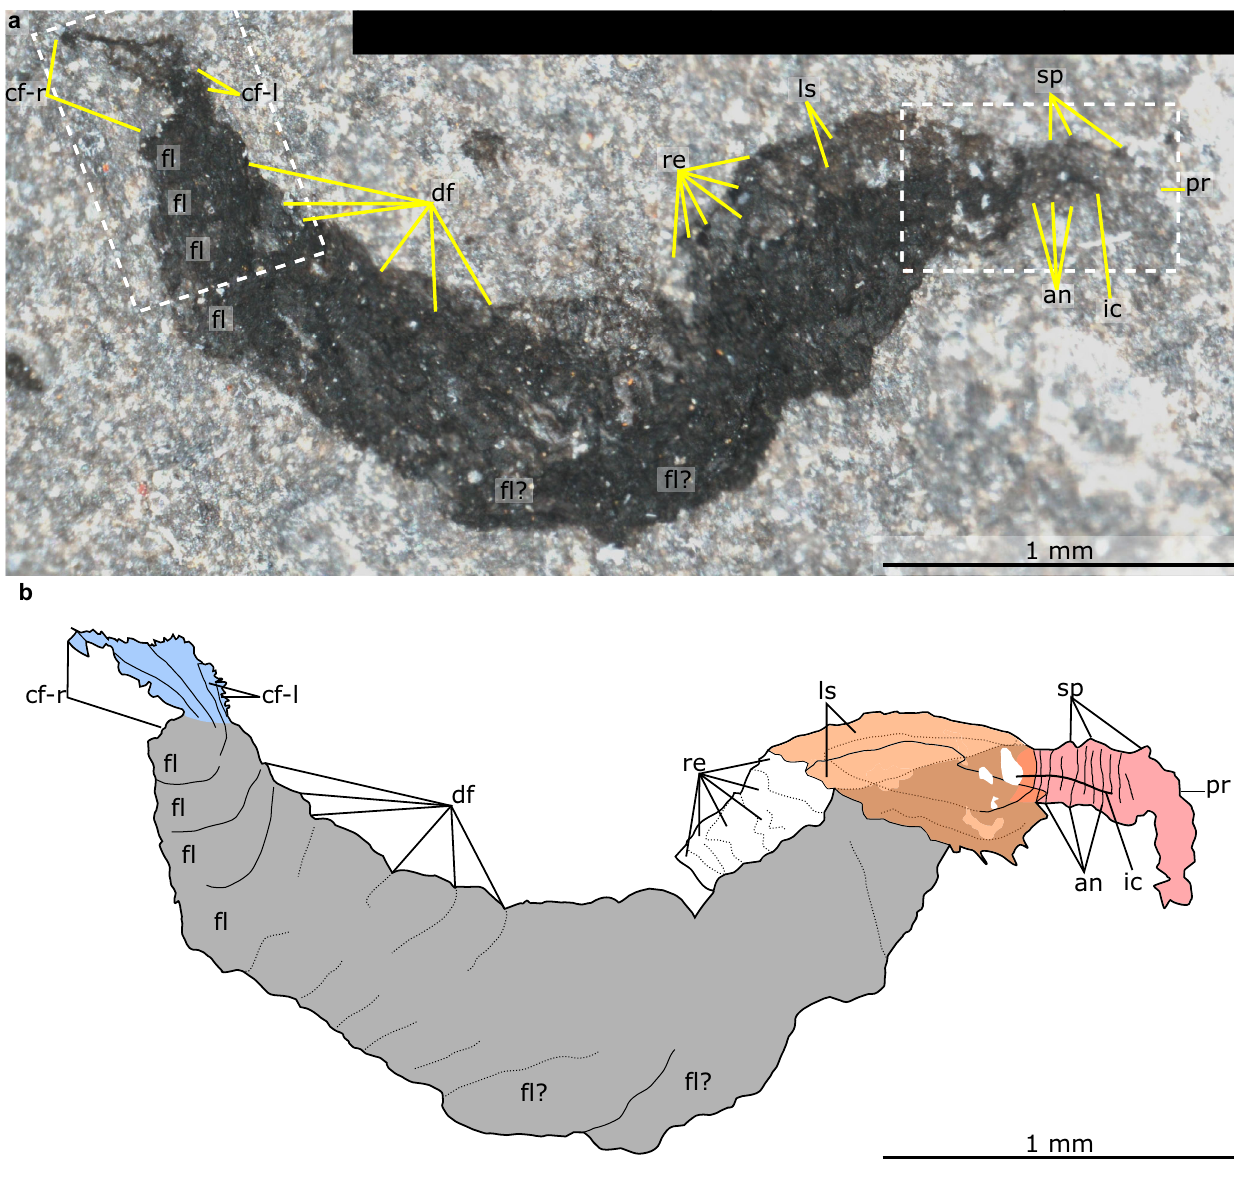
Fig. 6 | Castle Bank euarthropod A (NMW.2021.3G.8) from the Castle Bank biota. a Overview of whole specimen. Boxes indicate areas detailed in Fig. 7. b Explanatorydrawing of ( a ).anannulationsof proboscis, cf-lleftbladesofcaudal